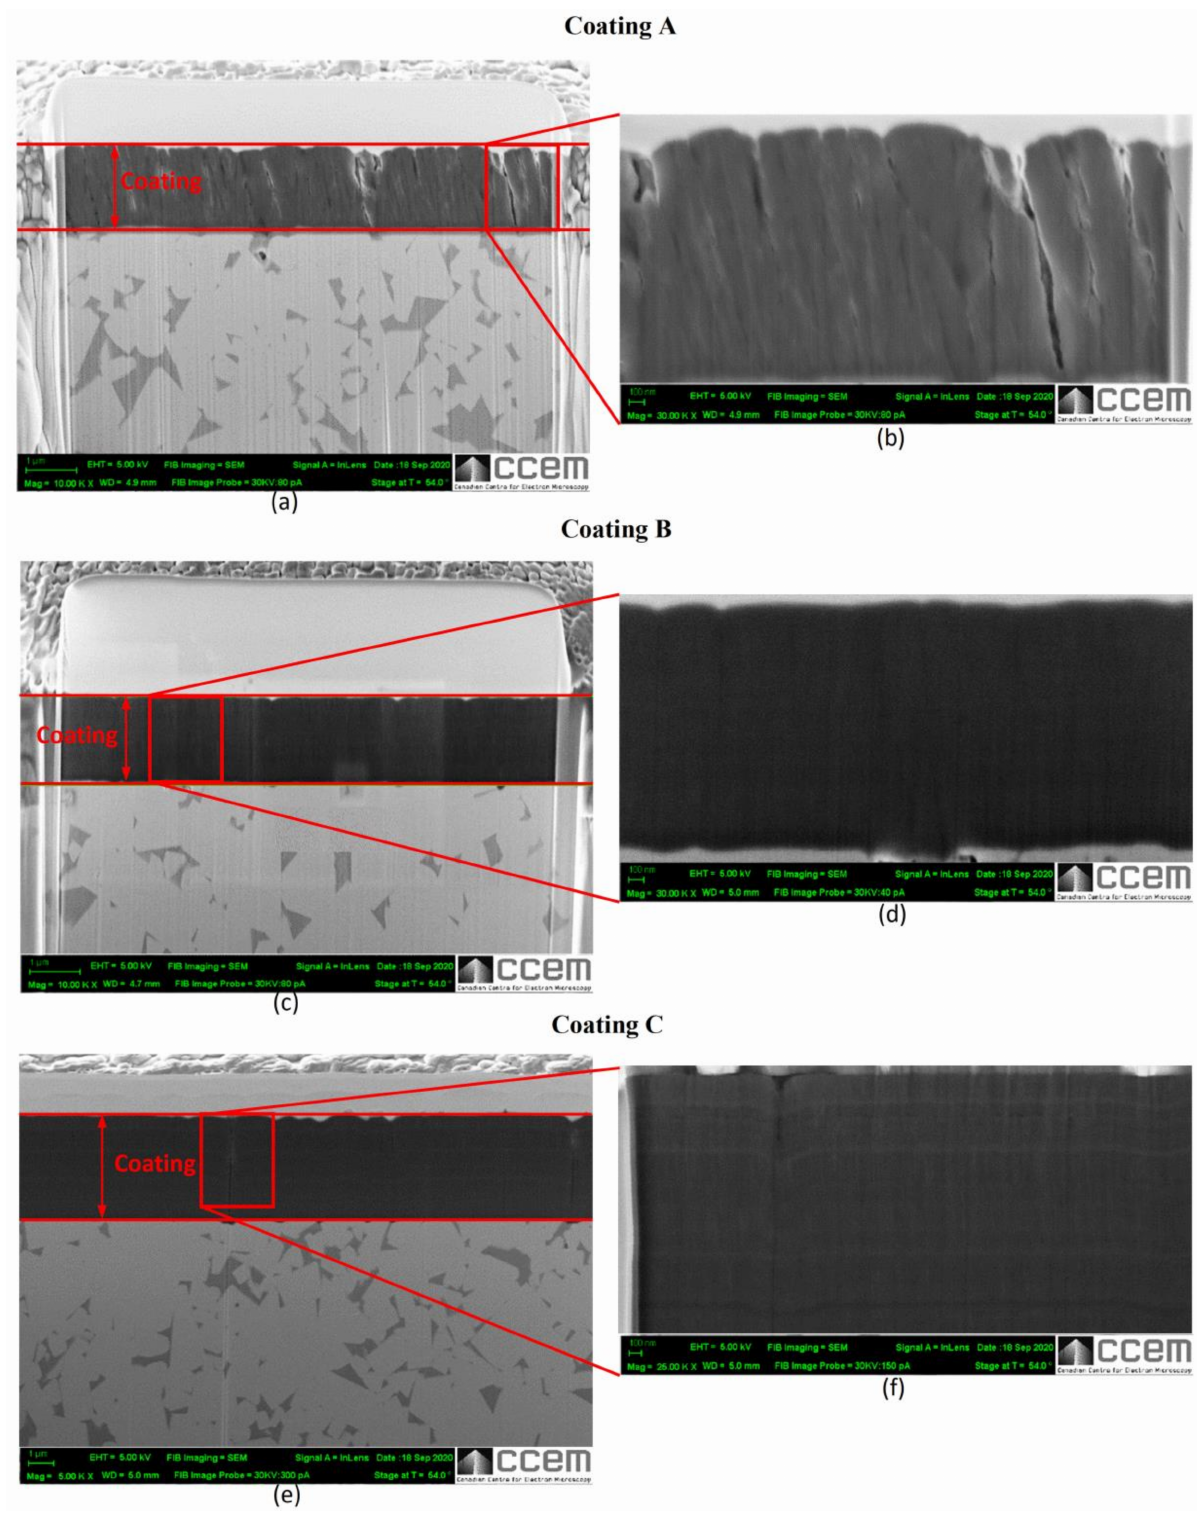
Figure 8. SEM images of FIB cross-sections of the three TiB 2 coatings showing coating thickness and structure: ( a , c , e ) at low magnification, ( b , d , f ) at high